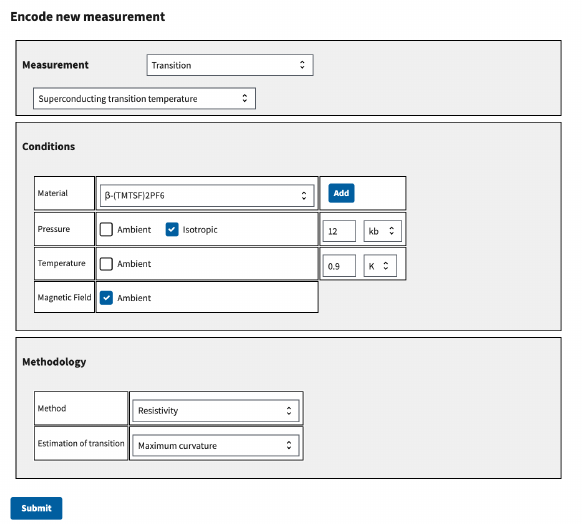
Figure 4. View of the web application used for data entry. In this example, the T c of β -(TMTSF) 2 PF 6 under 12 kbar of applied pressure is specified to be 0.9 Kelvin as reported in